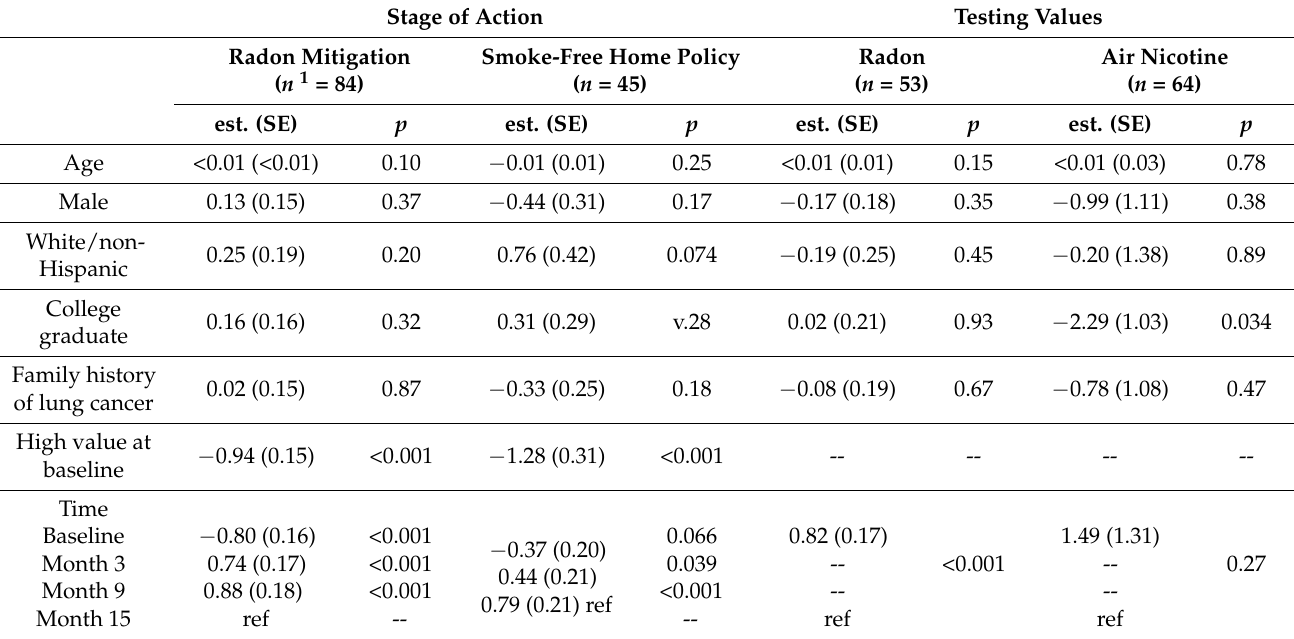
Table 2. Estimates from mixed models for stage of action outcomes and testing results.